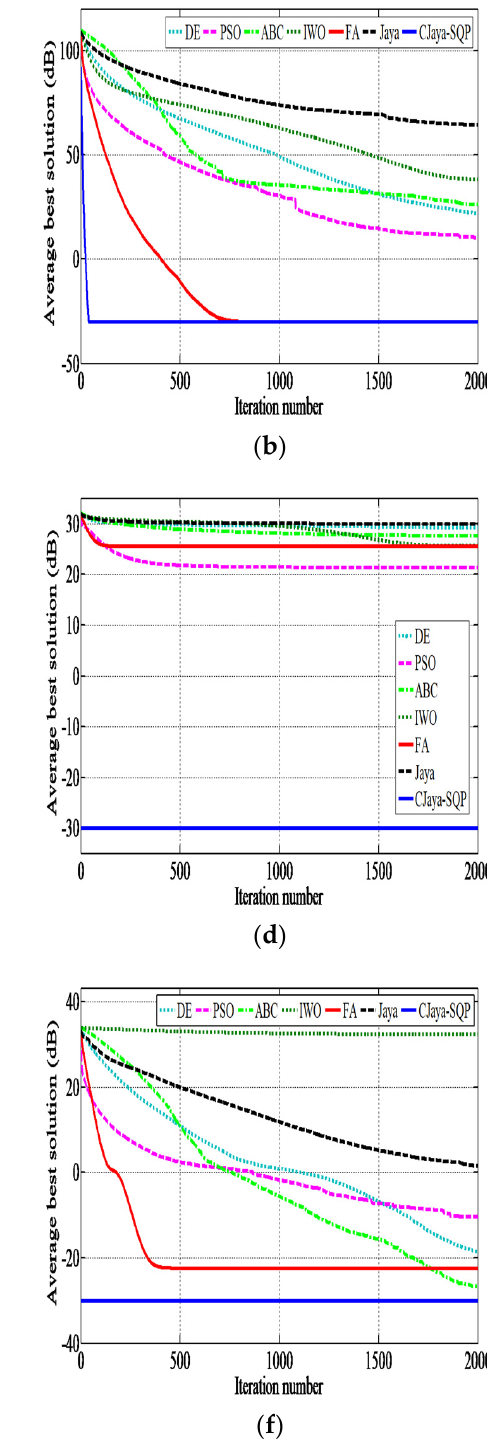
Figure 13. Convergence characteristics of comparative algorithms on the 100-dimensional conven- tional functions: ( a ) f 1 Sphere; ( b ) f 4 Zakharov; ( c ) f 5 Rosenbrock; ( d ) f 7 Salomon; ( e ) f 8 Ackley and ( f ) f 9 Griewank.